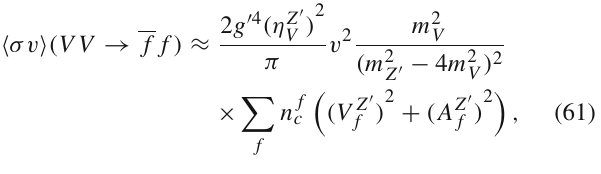
= 1. In both cases V